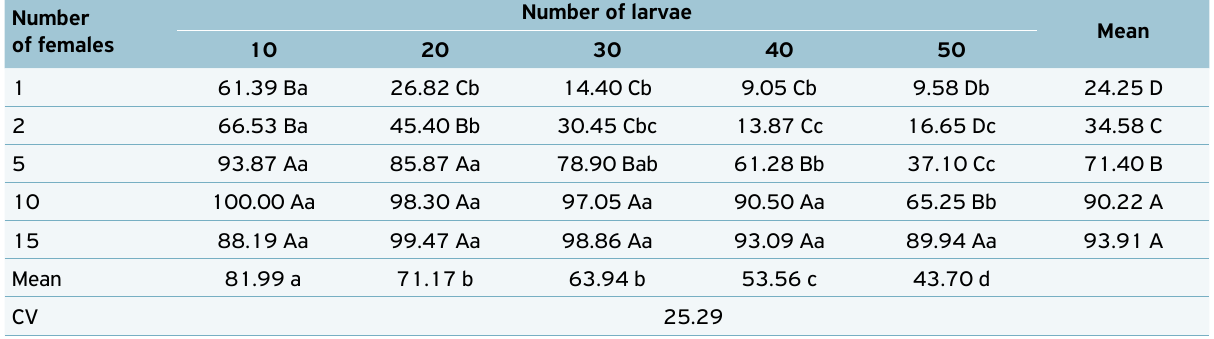
1 Different letters mean significance between the means, in the lines (lower case) and columns (upper case) (p<0.05); CV: coefficient of